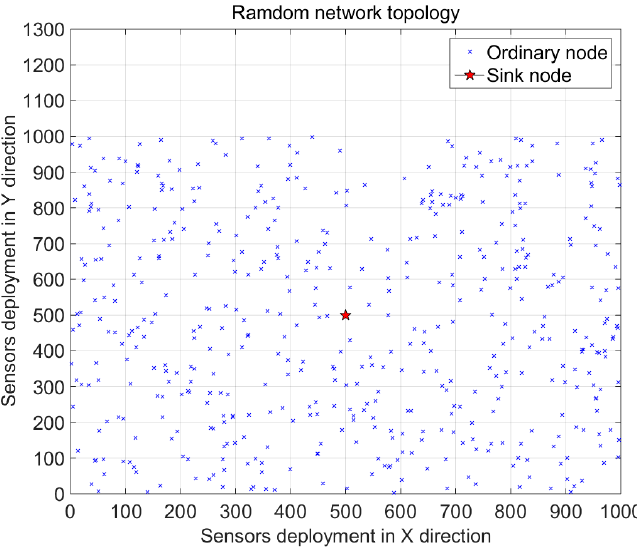
Figure 5. Random deployment of 500 sensor nodes.